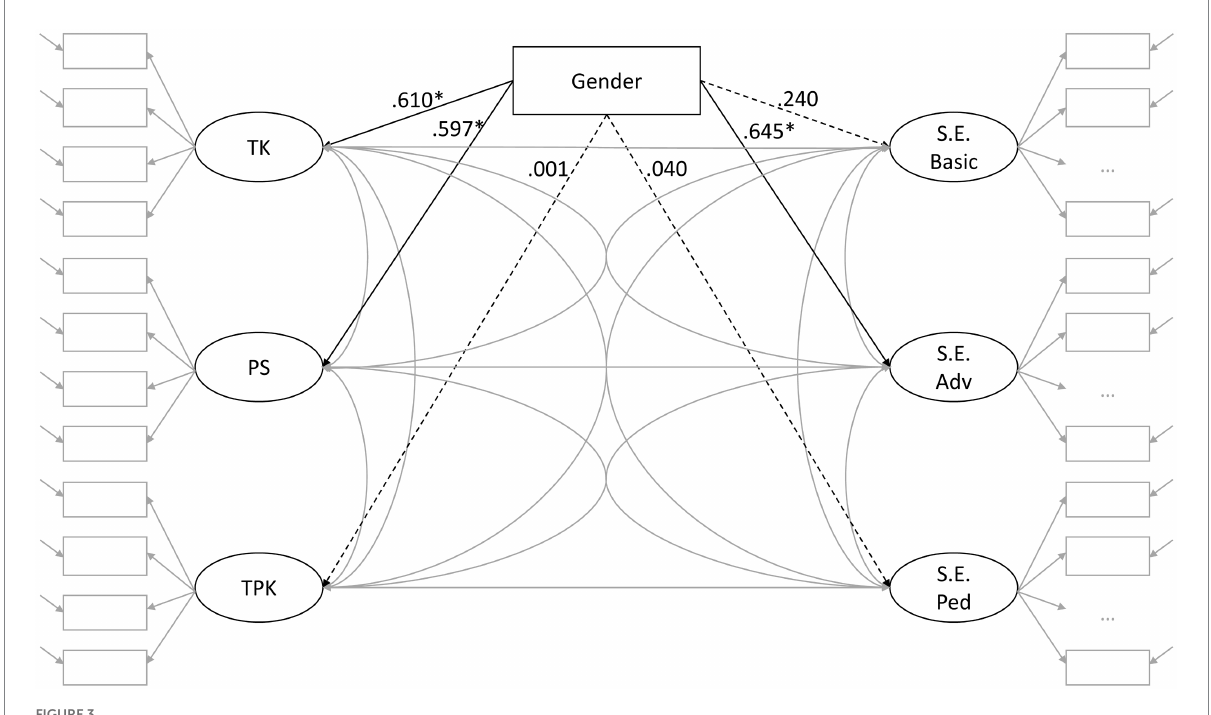
FIGURE 3 Standardized regression coefficients for gender (1: female, 2: male; *: significant at 𝛼 = 0.05, N =